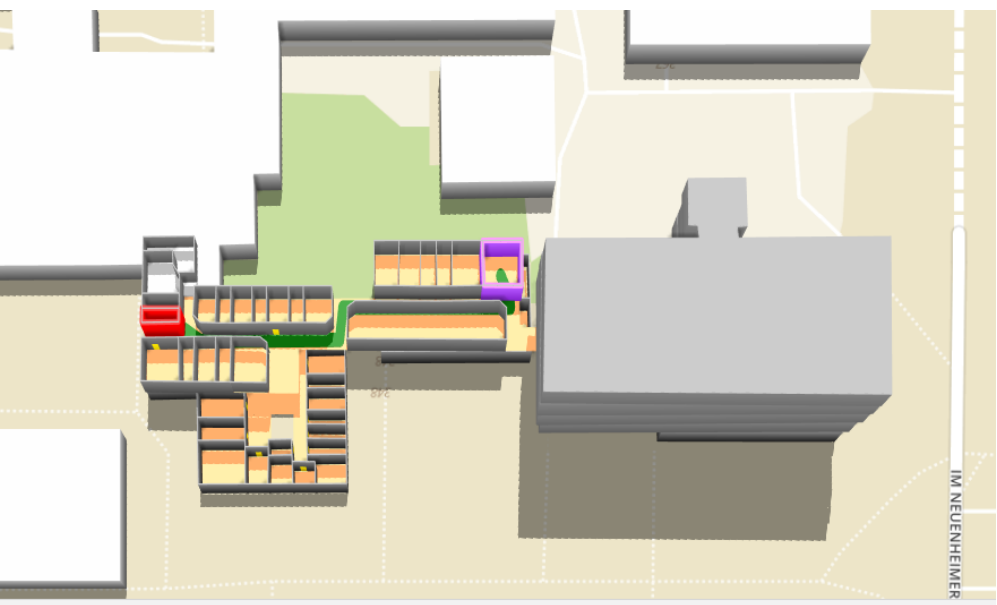
Figure 16. Route R8 from Room 133 (in red) to Room 112 (in purple) in the Geography